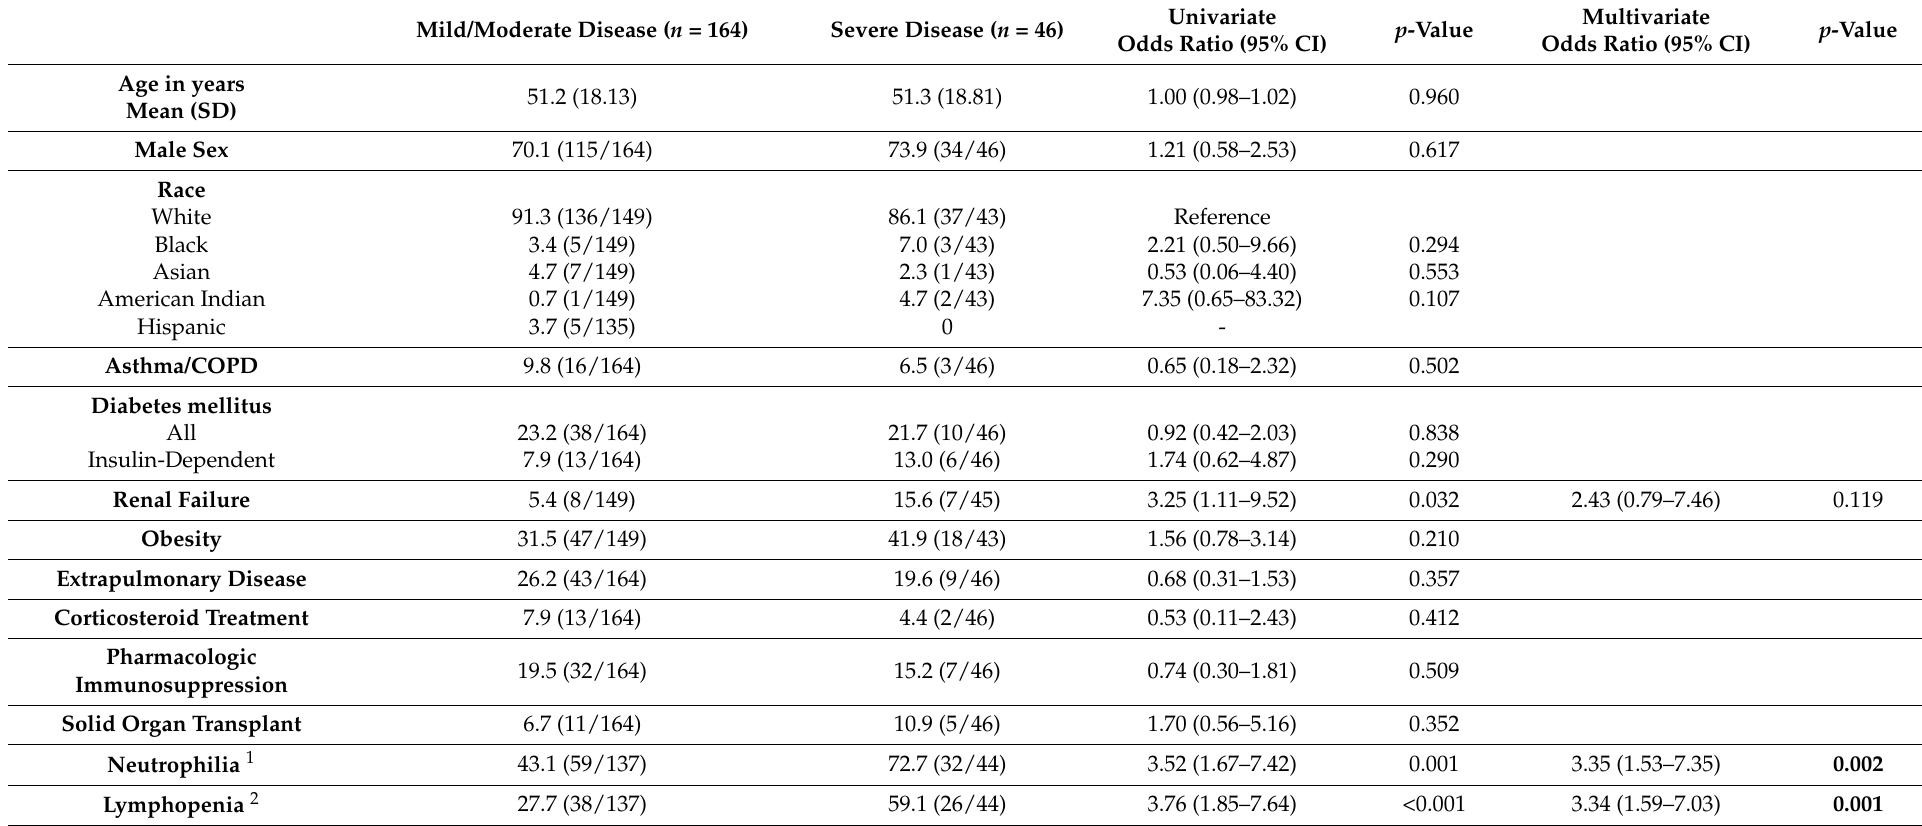
Table 2. Risk factors for severe